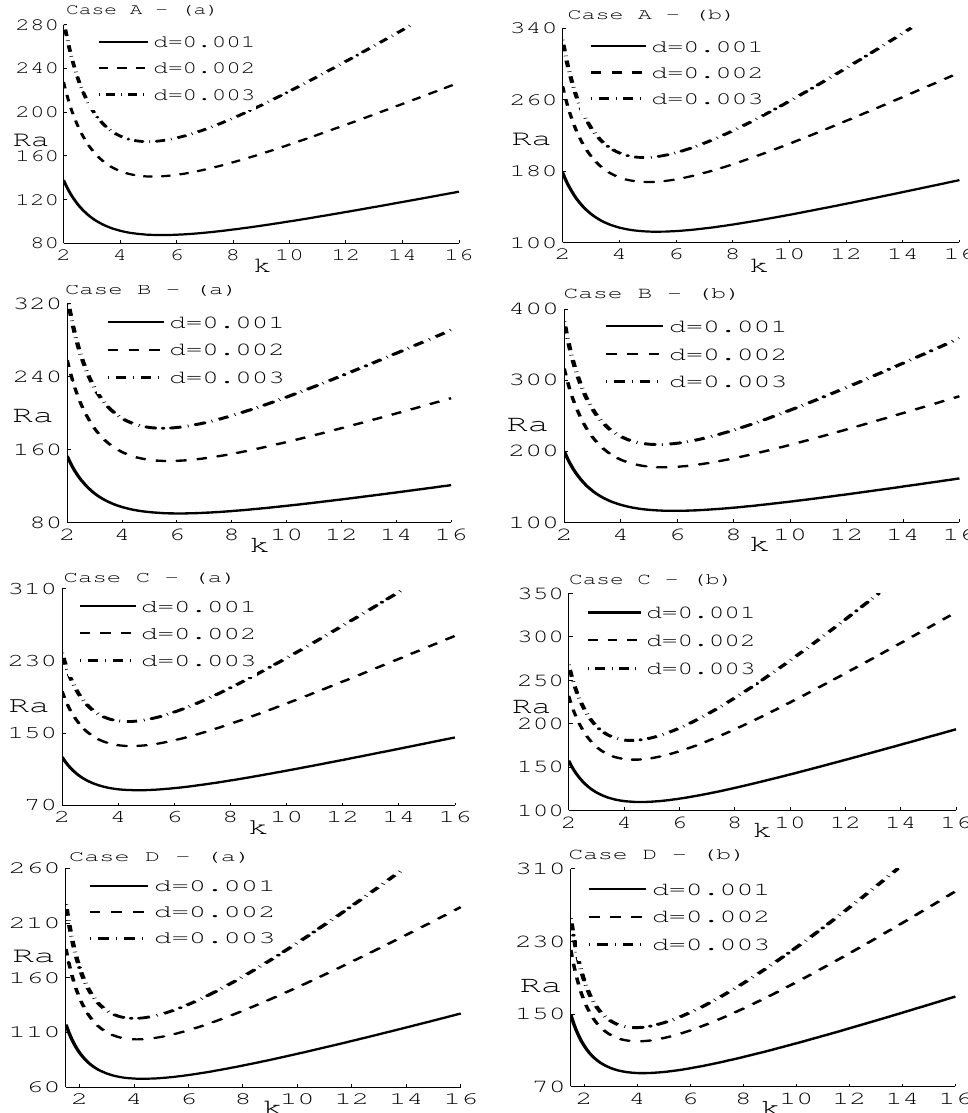
Figure 3. Neutral curves for different values of the width of ferrofluid layer d for ( a ) water-based ferrofluid and ( b ) ester-based ferrofluid for Case A to Case D. The fixed parameter values are α L = 2, (cid:101) = 0.35, and K = 2.0 × 10 − 7